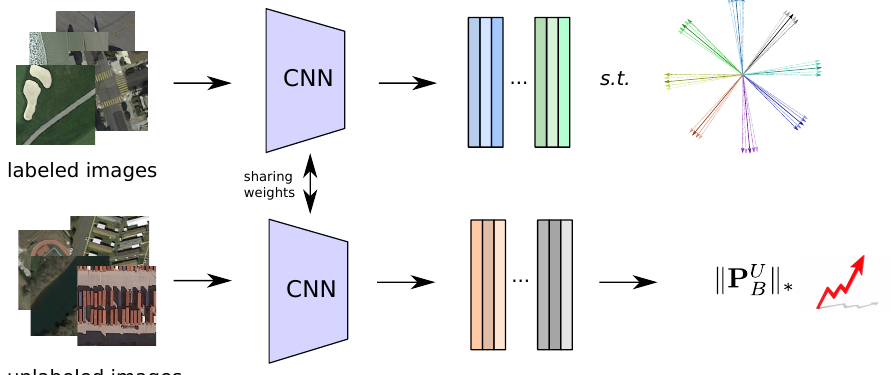
Figure 1. Proposed semi-supervised deep metric learning model, which consists of two different segments that use the same CNN backbone architecture with shared weights. The top segment covers the labeled RS scenes by the normalized softmax loss with margin, whereas the bottom segment employs the high-rankness regularization over the unlabelled